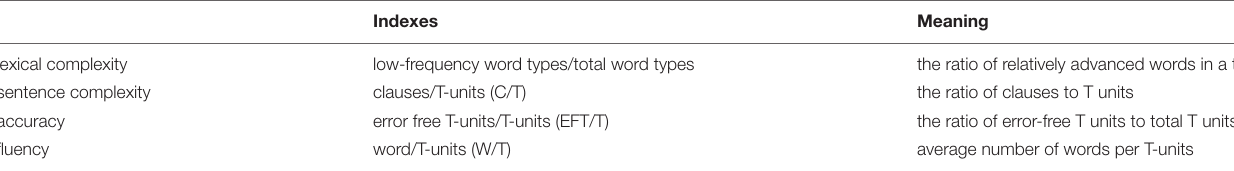
Indexes Meaning